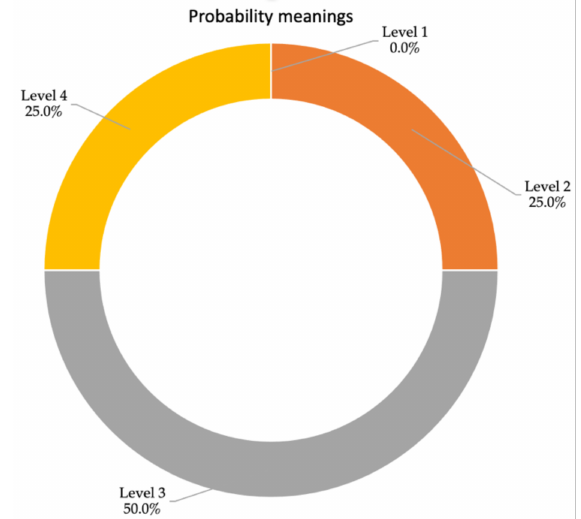
Figure 10. Probability meanings by